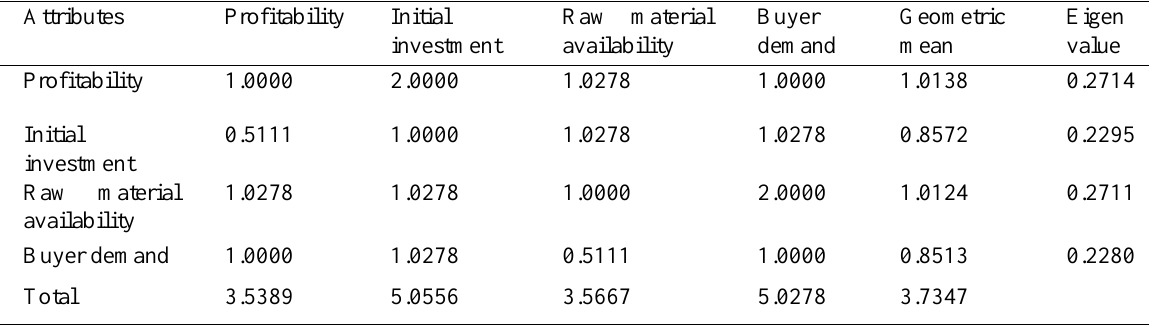
Table 5.1. Calculating Geometric mean, Eigen value using Crisp AHP method for Table